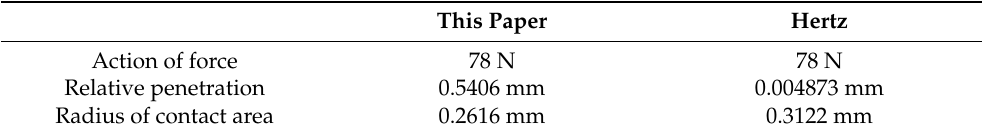
Table 2. Comparison results.